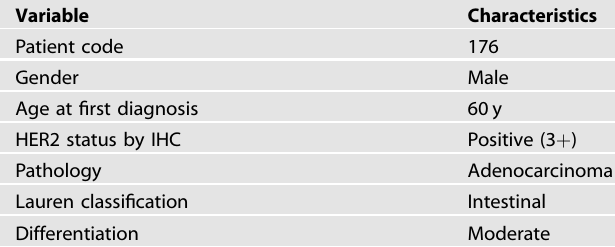
Table 1. The clinicopathological characteristics of case 176.